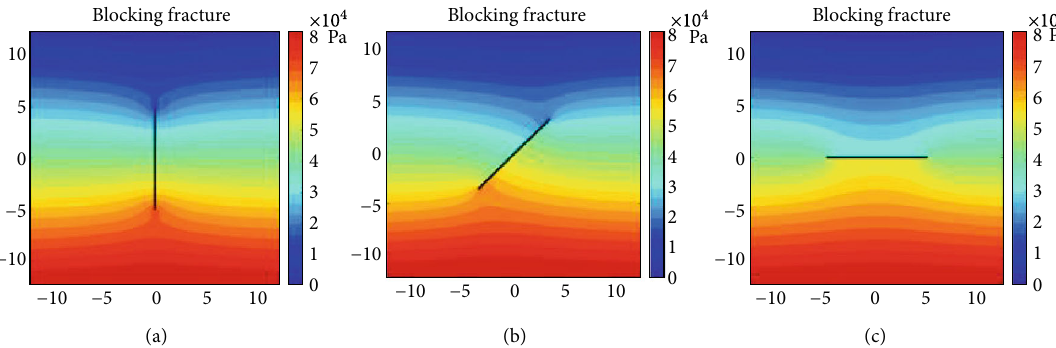
Figure 11: Pressure contours (in Pa) for cemented fractures with the same properties as Figure 11 but with e ff ective fracture strength reduced by a factor of 2 to a value of − 1 : 90 × 10 − 6 m 4 /s .